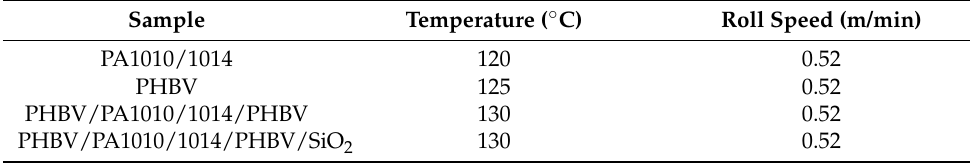
Table 1. Thermal post-treatment conditions for the mono- and multilayer